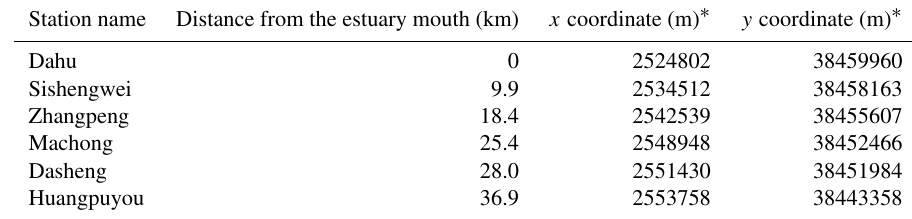
Table 1. General information of hydrological stations in the Humen waterway.